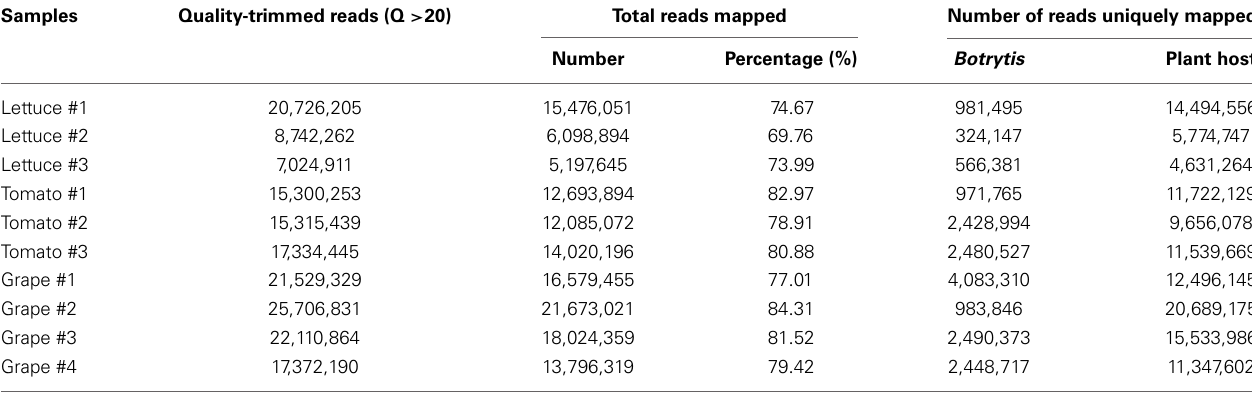
Table 1 | Summary of trimmed and mapped reads of mRNA from Botrytis -infected tissues.